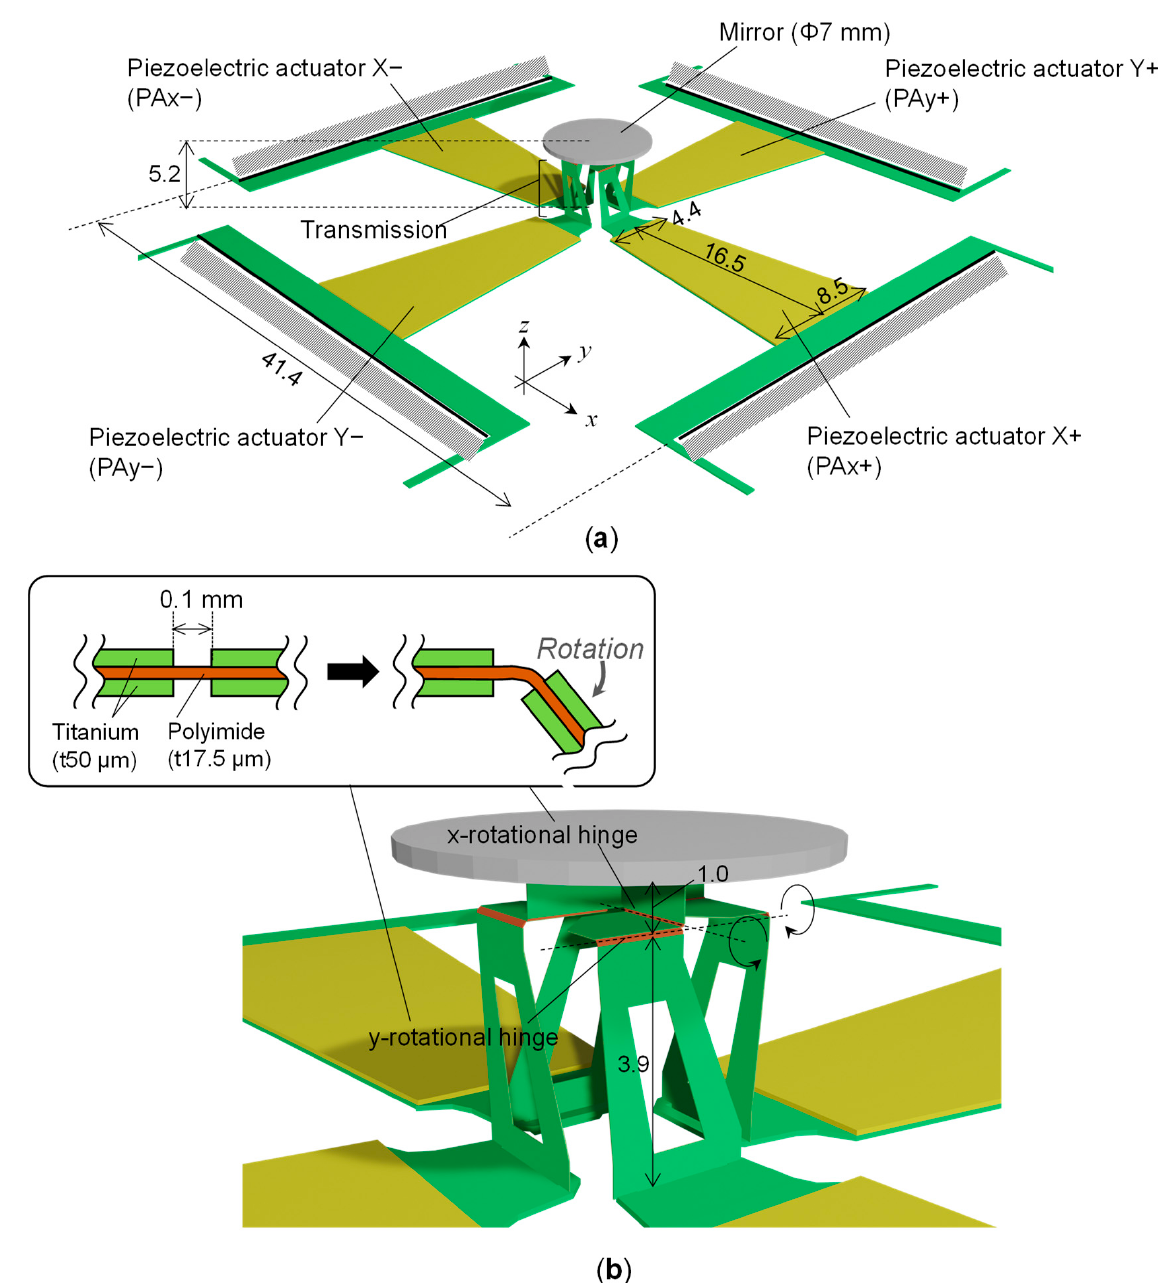
Figure 1. Structure of the developed scanner: ( a ) overall view and ( b ) close-up view of the transmission mechanism.